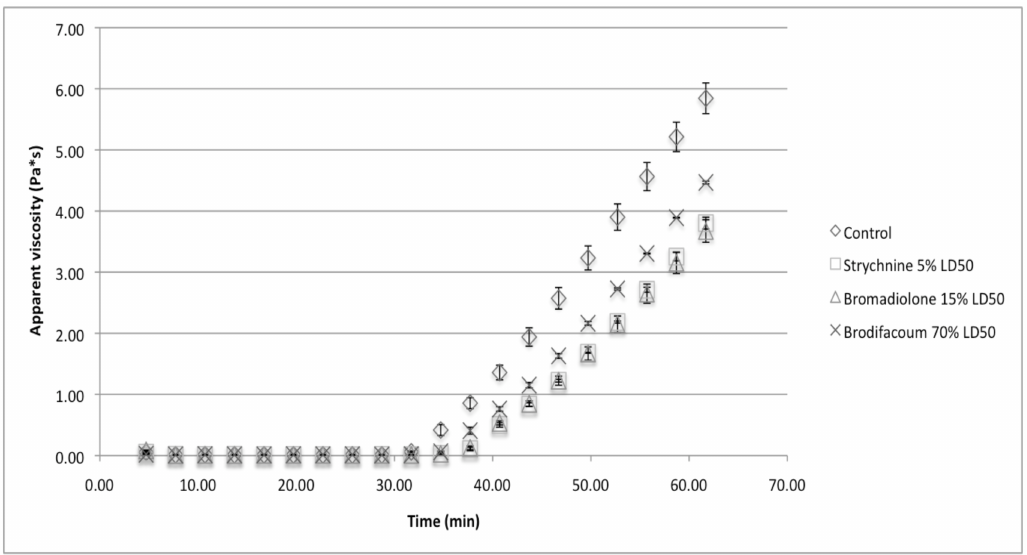
Figure 3. Impact of rodenticides on the apparent viscosity of